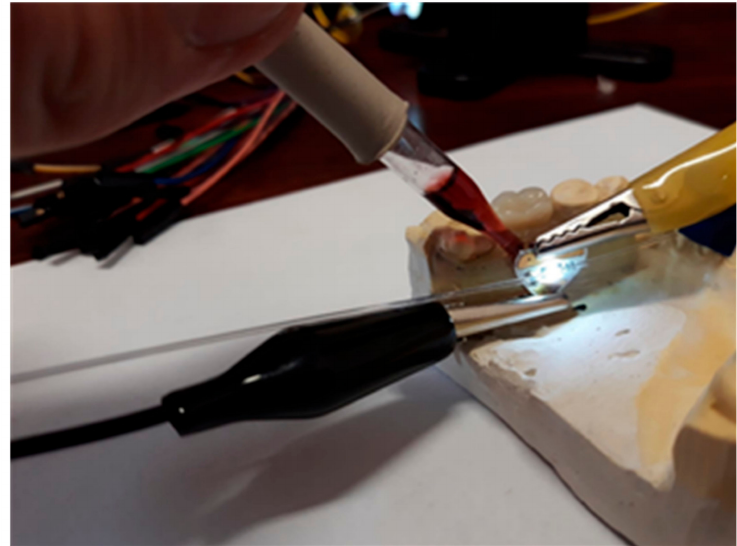
Figure 13. Illustration of the intra-oral optical sensor test procedure for wine color analysis, which assumes having the sensor integrated into a mouthguard and mounted onto a custom jaw